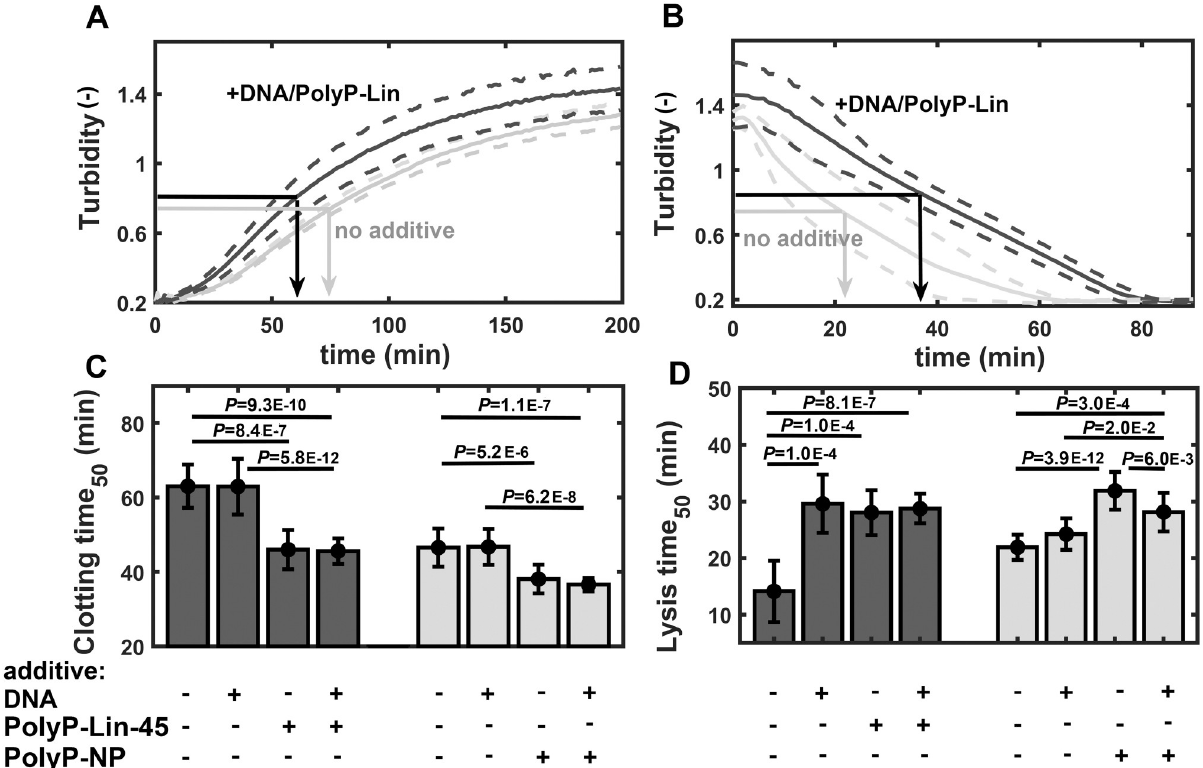
Fig 3. Combined effects of DNA and polyphosphates on fibrin formation and lysis. Fibrinogen (7 μ M) containing plasminogen (0.2 μ M) was clotted by thrombin (2 nM) in the presence or absence of DNA (50 μ g/ml), linear PolyP (330 μ M) or PolyP-NP (330 μ M) and the absorbance at 340 nm (Turbidity) was measured (Panel A). At the plateau phase tPA (140 nM) was layered on the surface of clots and measurement was continued until complete lysis (Panel B). Arrows indicate the time to reach half-maximal turbidity (clotting time 50 and lysis time 50 ) in the ascending and descending phase of the representative turbidimetric curves in panels A and B, respectively. Median values and interquartile range (error bars) of clotting time 50 (Panel C) and lysis time 50 (Panel D) are shown in black (no Ca 2+ ) or grey (1.67 mM Ca 2+ ). P -values for differences of the indicated pairs of datasets are shown according to Kolmogorov-Smirnov test (n =